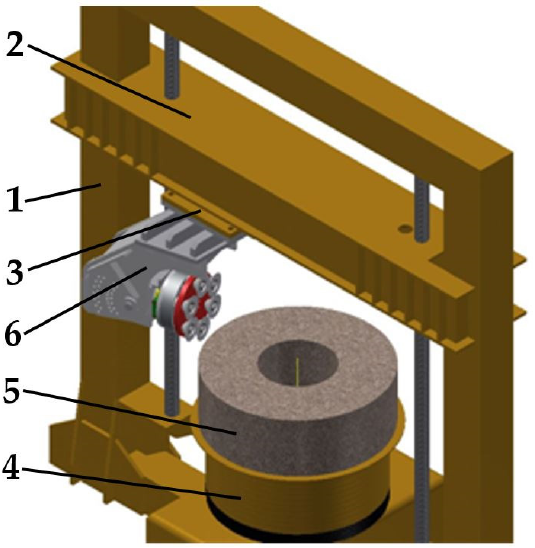
Figure 19. The 3D model of a lab stand for testing mining process of compact rocks with a com- plex-motion trajectory milling plate, equipped with asymmetrical mini-disk tools: [29]. 1—main- frame, 2—traverse, 3—support with the tool holder, 4—rotary table, 5—mined rock sample, 6—special device for the fixing of a disk